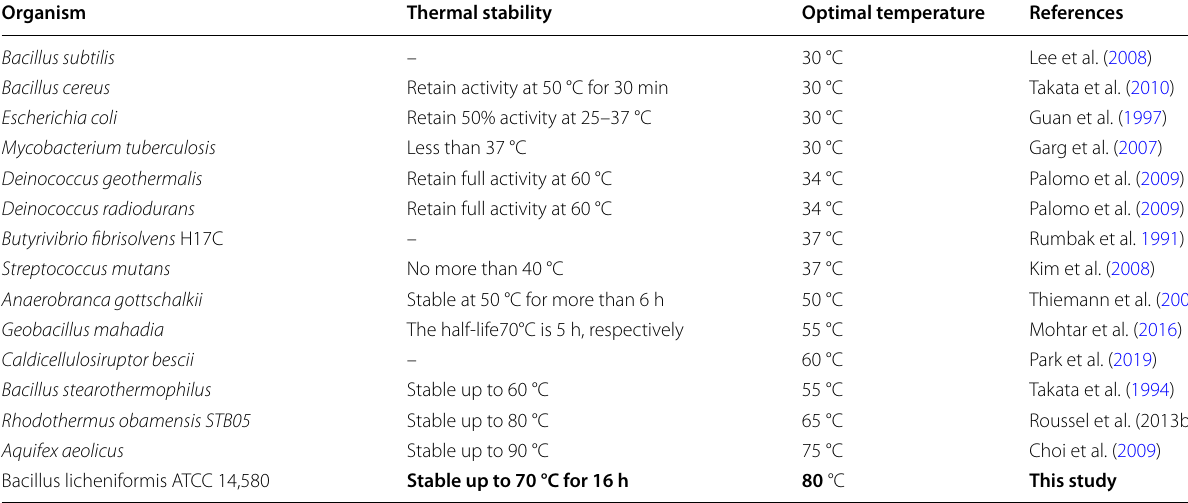
Table 5 Optimal temperature and thermal stability of branching enzymes from different organisms. bl-GBE in this study is displayed in bold